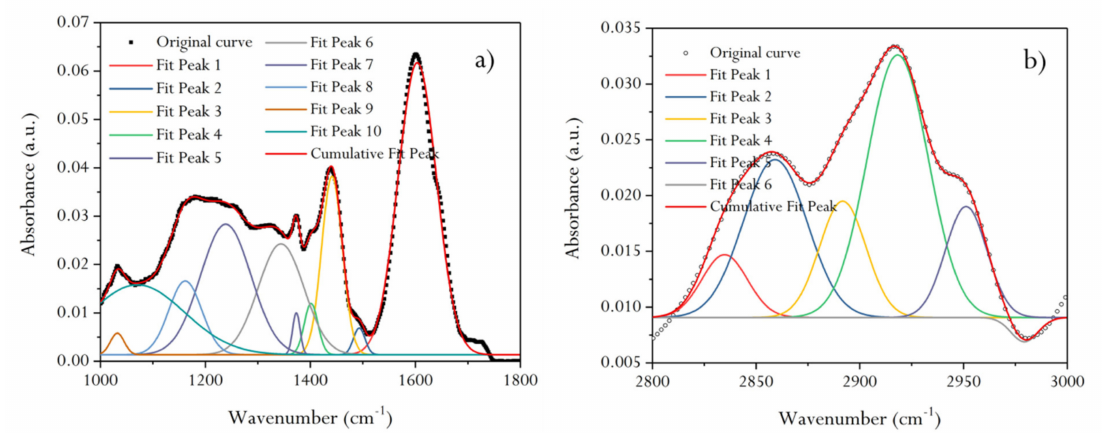
Figure 7. Infrared spectrum fitting diagram of the demineralized HNC in the 1000–1800 and 2800–3000 cm − 1 band. ( a ) 10 sub-peaks are obtained by peak fitting in the 1800–1000 cm − 1 . ( b ) The fitting number of sub-peaks between 3000 and 2800 cm − 1 is 6. The mathematical function model of fitting peak is Gaussian